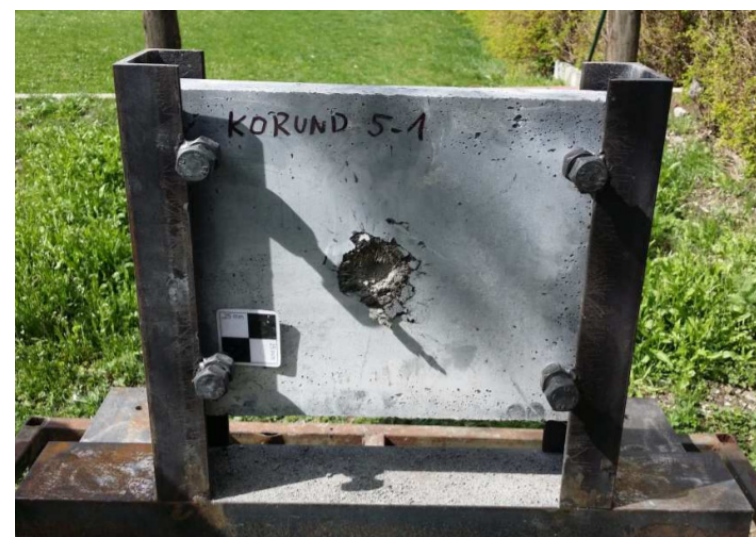
Figure 4. Special anchoring structure for seating test samples.